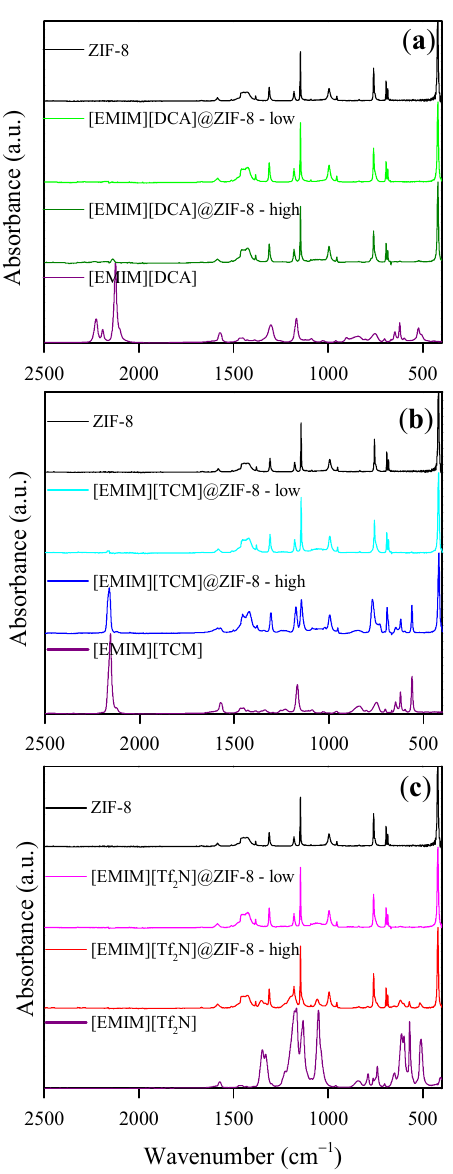
Figure A2. Normalized FT-IR spectra of (from top to bottom): ZIF-8, IL@ZIF-8 composites and neat IL, of ( a ) [EMIM][DCA]; ( b ) [EMIM][TCM]; and ( c ) [EMIM][Tf 2 N].